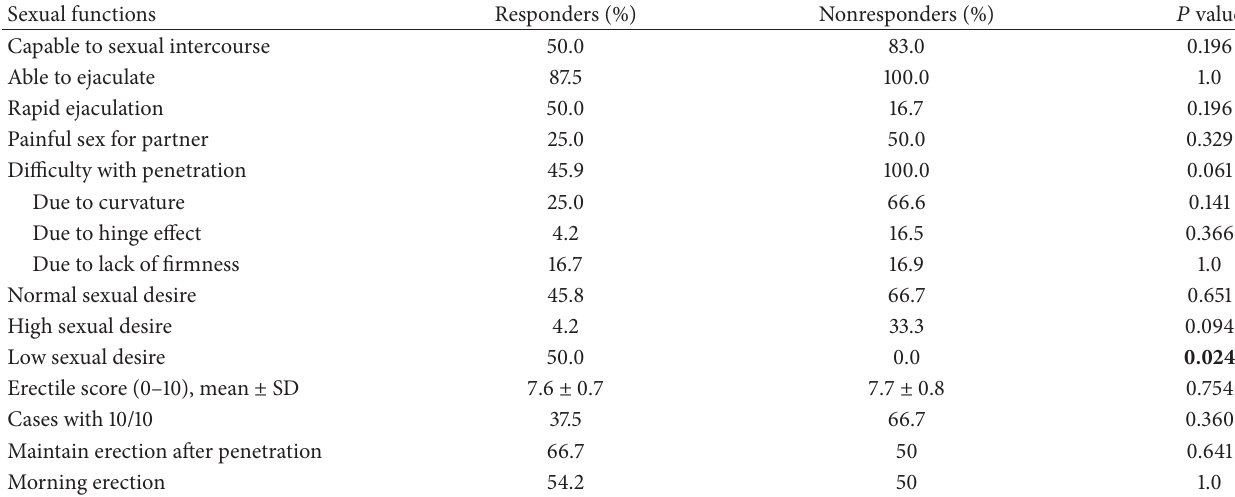
Table 4: Self-report on quality of sex and erectile and sexual functions prior to EMDA therapy among men who either expressed benefit or not improved using the treatment.